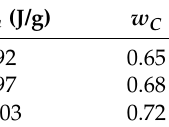
Figure 3. Specific heat capacity ( c p ) of PHBV and PHBV mixed with ( i ) ATBC and ( ii ) ATBC and the mineral filler CaCO 3 at the concentrations indicated. The curves were obtained upon heating at 10 K/min after previous fast cooling to − 85 °C. The ordinate values refer only to the bottom curve. All the other curves are shifted vertically for the sake of clearness.